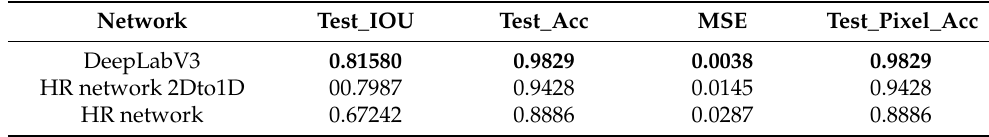
Table 4. Semantic segmentation based on rhythmic